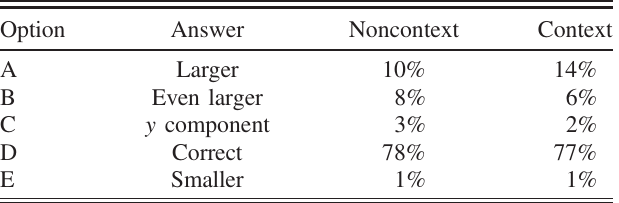
TABLE IX. Results of item 7: Students have to choose the x component of a vector or force .